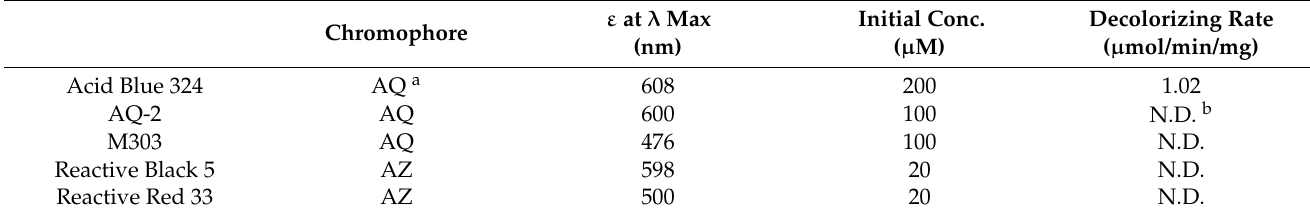
Table 2. Dye-decolorizing activity of purified SaDyP1 toward anthraquinone or azo.